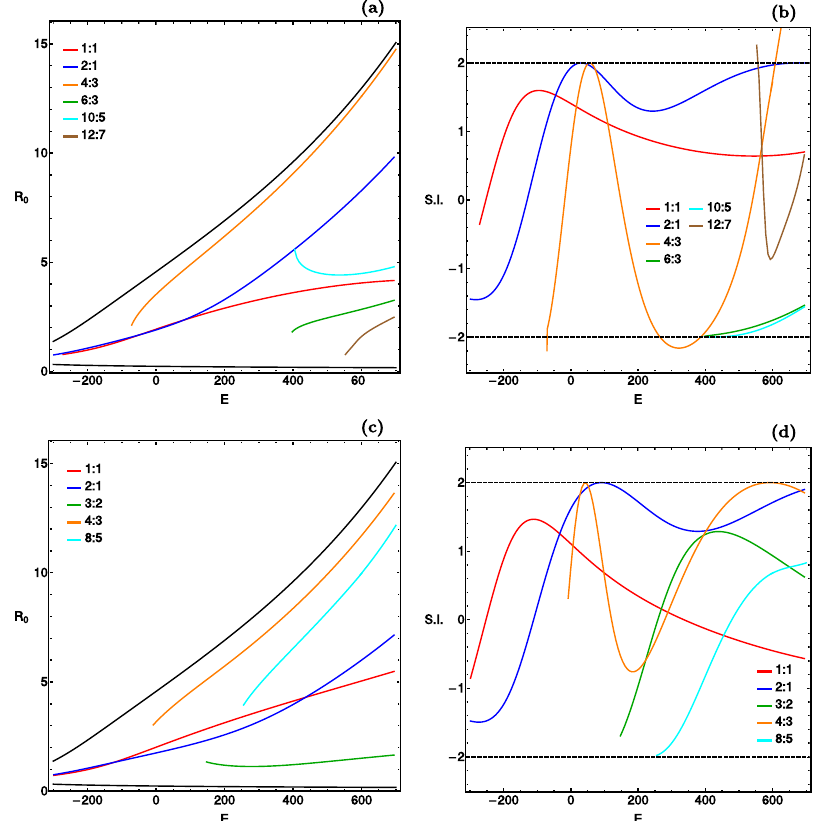
Fig. 10. Evolution of the R coordinate of periodic orbits as a function of the total orbital energy ( E ) for the PH models (panel a) and OH models (panel c), and the evolution of the stability index S.I. as a function of E for the PH models (panel b) and OH models (panel